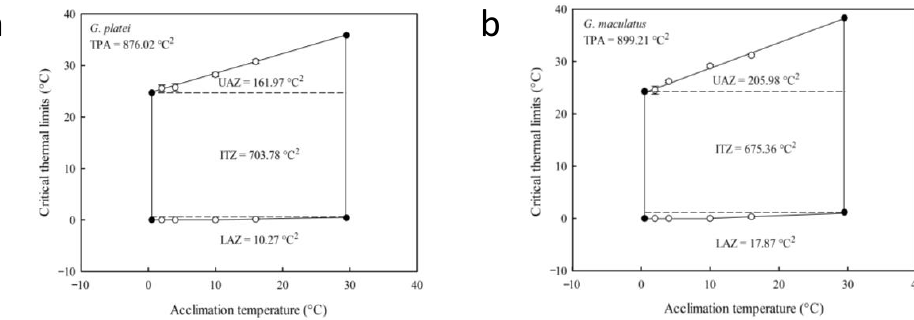
Figure 2. Thermal tolerance polygons for ( a ) G. platei and ( b ) diadromous G. maculatus from Tierra del Fuego. Polygons were constructed using Critical Thermal Maximum/Critical Thermal Minimum values (CTmax/CTmin, white circles, mean ± SD) measured at four acclimation temperatures (AT, 2, 4, 10 and 16 °C) within their total thermal acclimation range. Extreme CTmax/CTmin values (black circles), extrapolated from regression analyses of CTmax/CTmin values on AT, are indicated. The total polygonal area (TPA) is composed of the intrinsic tolerance zone (ITZ) and the upper and lower acquired tolerance zones (UAZ, LAZ).